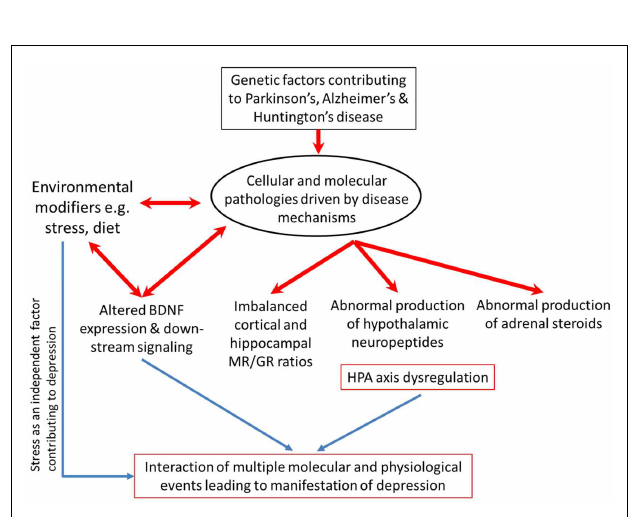
FIGURE 1 | Broad schematic of gene × environmental interactions potentially causative of the greater incidence of co-morbid depression inAD, PD, and HD